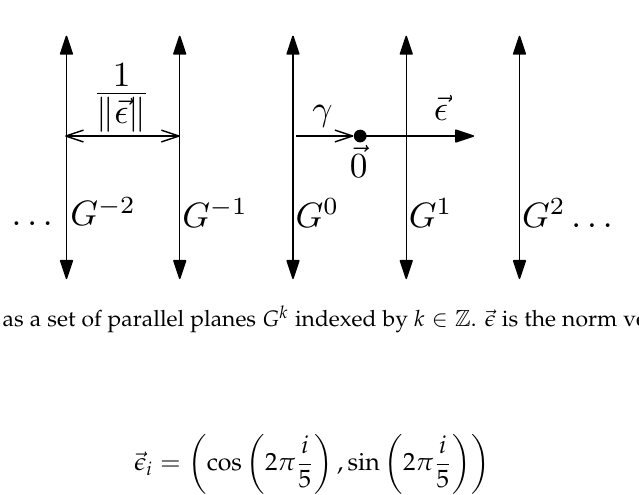
Figure 4. An example of a pentagrid where (cid:101) 0 , (cid:101) 1 ,..., (cid:101) 4 are the grid vectors.